Question: Express in one sentence what the figure is showing.
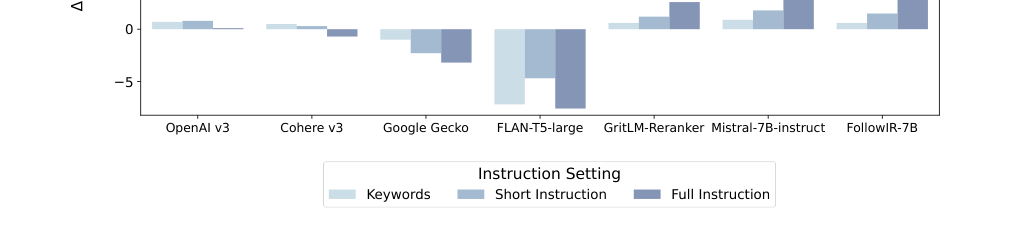
Answer: Score difference between using no instructions to using instructions formatted as keywords, short text, or the full text. While models that can correctly use instructions see gains with the additional information, most other models see decreasing performance as instruction length increases.